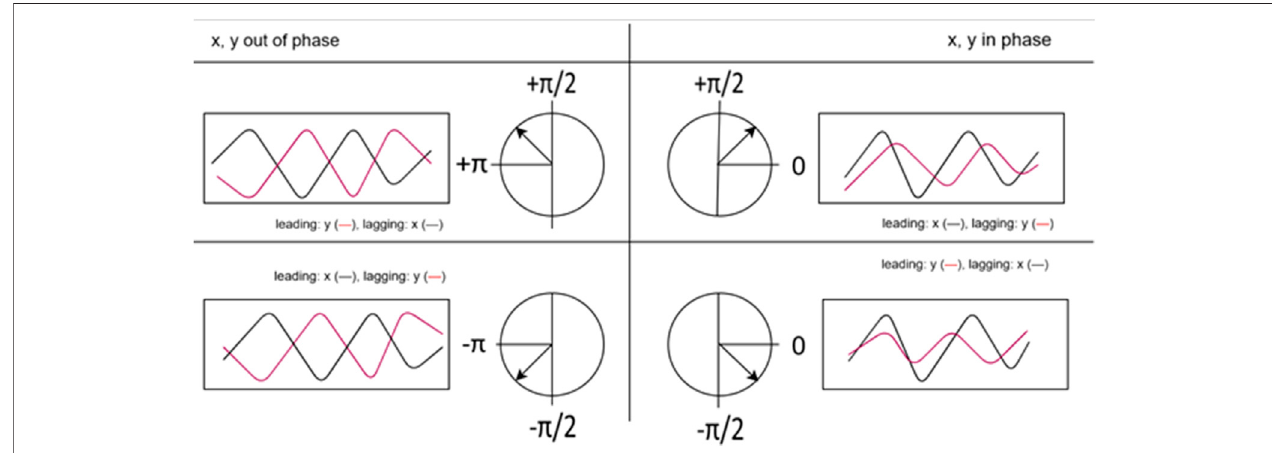
FIGURE 1 | Phase difference and their